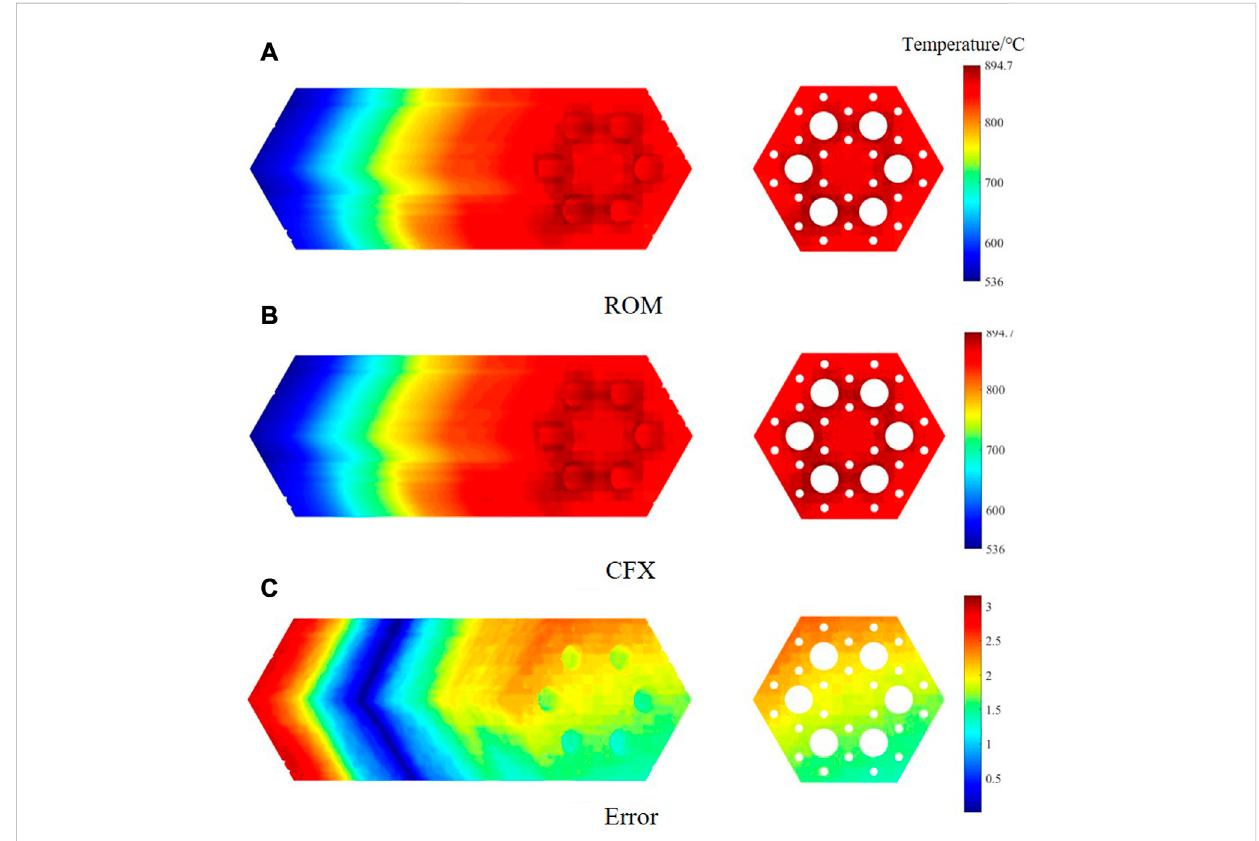
FIGURE 10 Temperature contour comparison for monolith zone. (A) ROM. (B) CFX. (C)